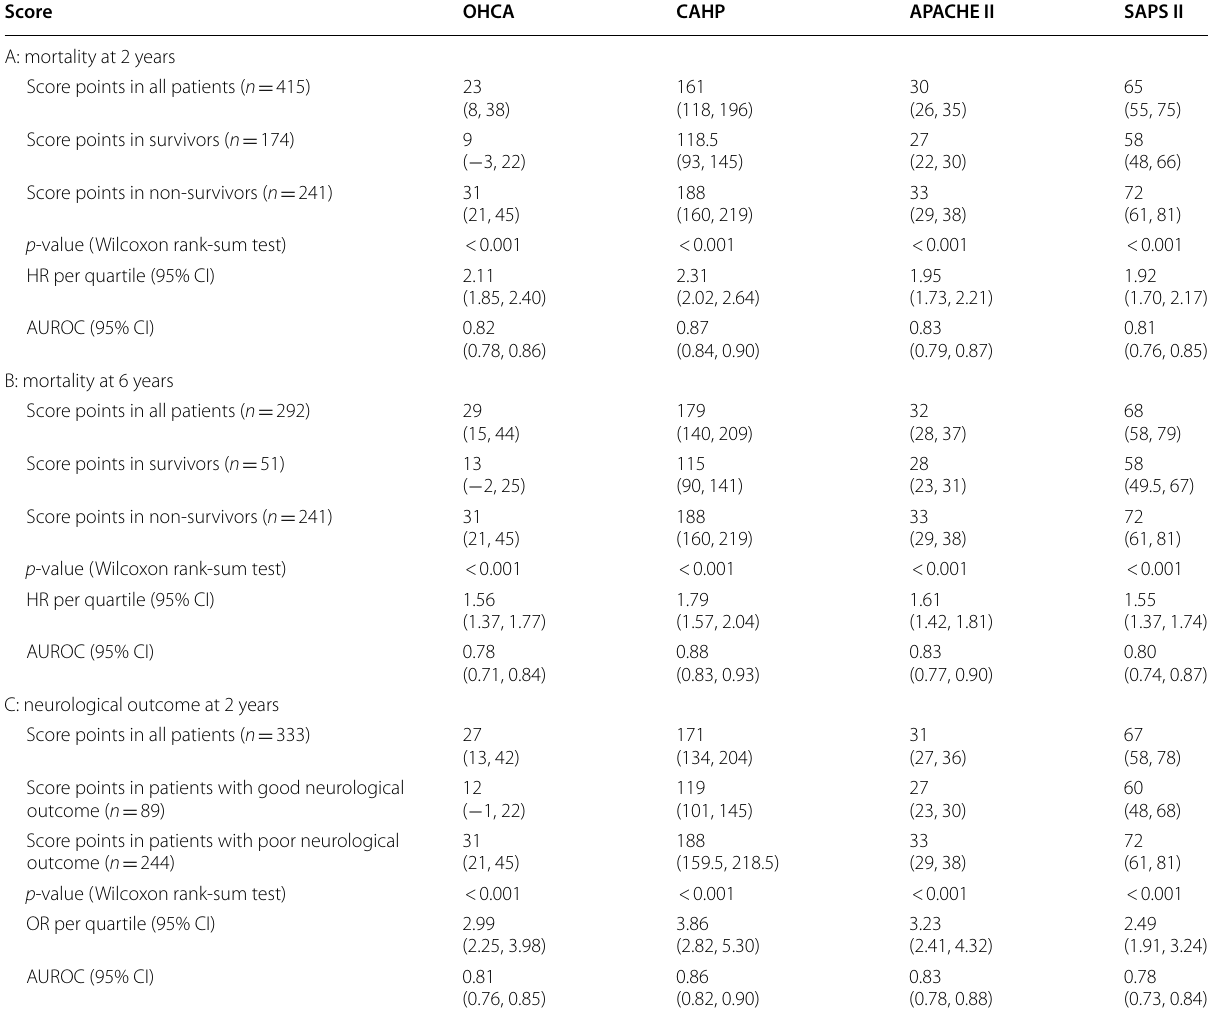
Table 2 Comparison of long-term prognostic performance between scores